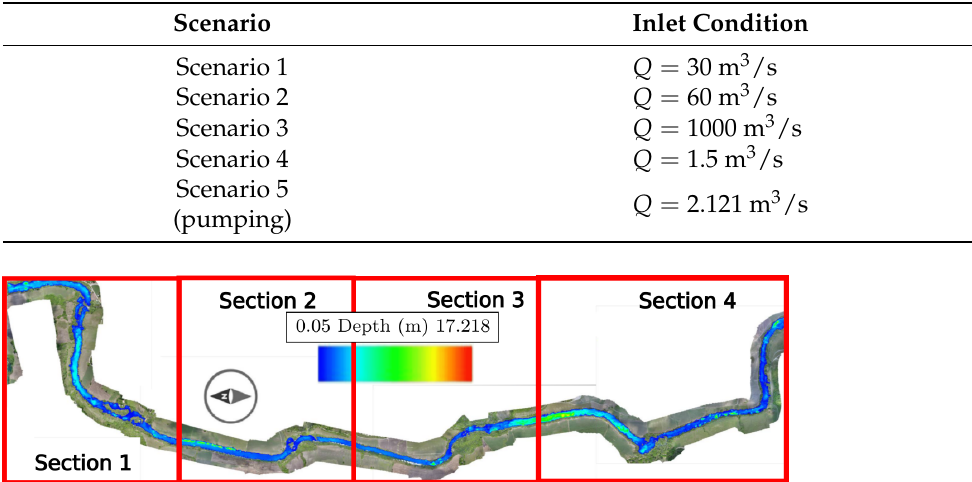
Figure 14. Initial free surface elevation for all the scenarios at on 9 August, 00:00 h. The entire studied river section is subdivided into subsections for convenience in explaining the